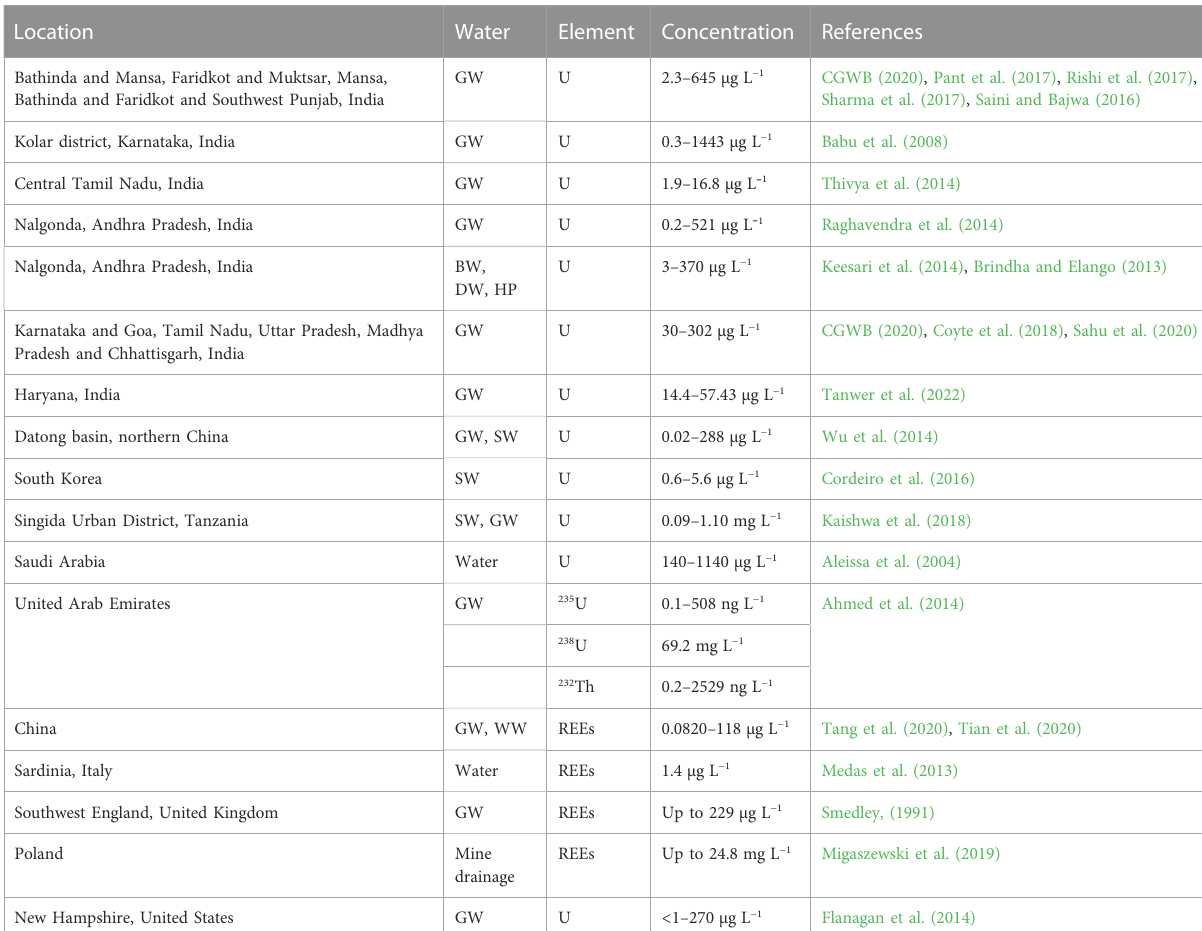
TABLE 4 Contents of U, Th and REEs in